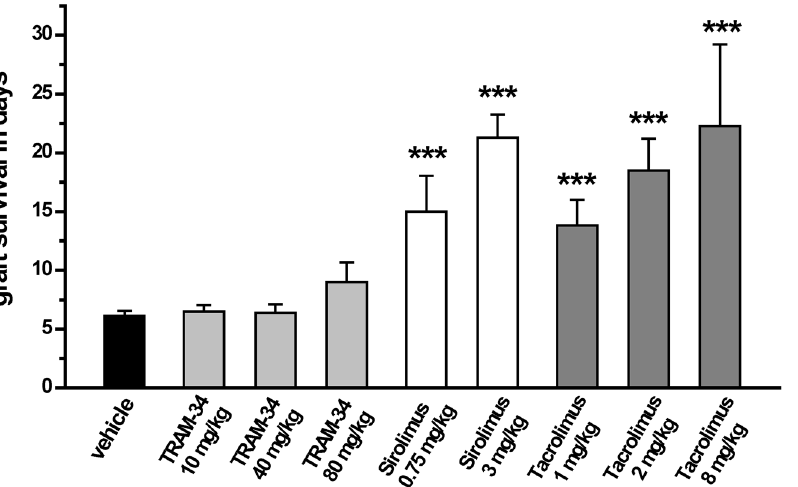
Figure 7. Graft survival times of heterotopic BN to Lewis heart transplants after a 10-day treatment period. Grafts were monitored by abdominal palpitation and defined as rejected when they reached a beating score of 0. Graft survival times in days: vehicle 6.2 6 0.4; TRAM-34 10 mg/kg 6.5 6 0.5; TRAM-34 40 mg/kg 6.4 6 0.7; TRAM-34 80 mg/kg 9 6 1.4; sirolimus 0.75 mg/kg 15 6 3.3; sirolimus 3 mg/kg 21.3 6 1.9; tacrolimus 1 mg/kg 13.8 6 2.2; tacrolimus 2 mg/kg 18.5 6 2.7; tacrolimus 8 mg/kg 22.3 6